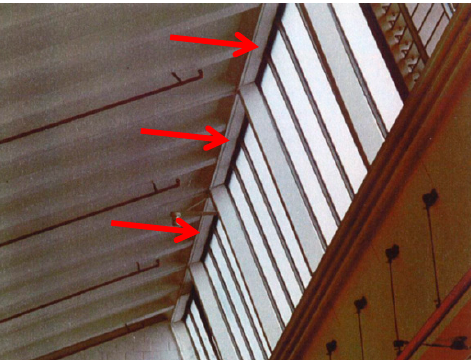
Figure 12. Detail of the inside of the building. The red arrows indicate the location of the steel plates. The photo was taken in the year 1992.